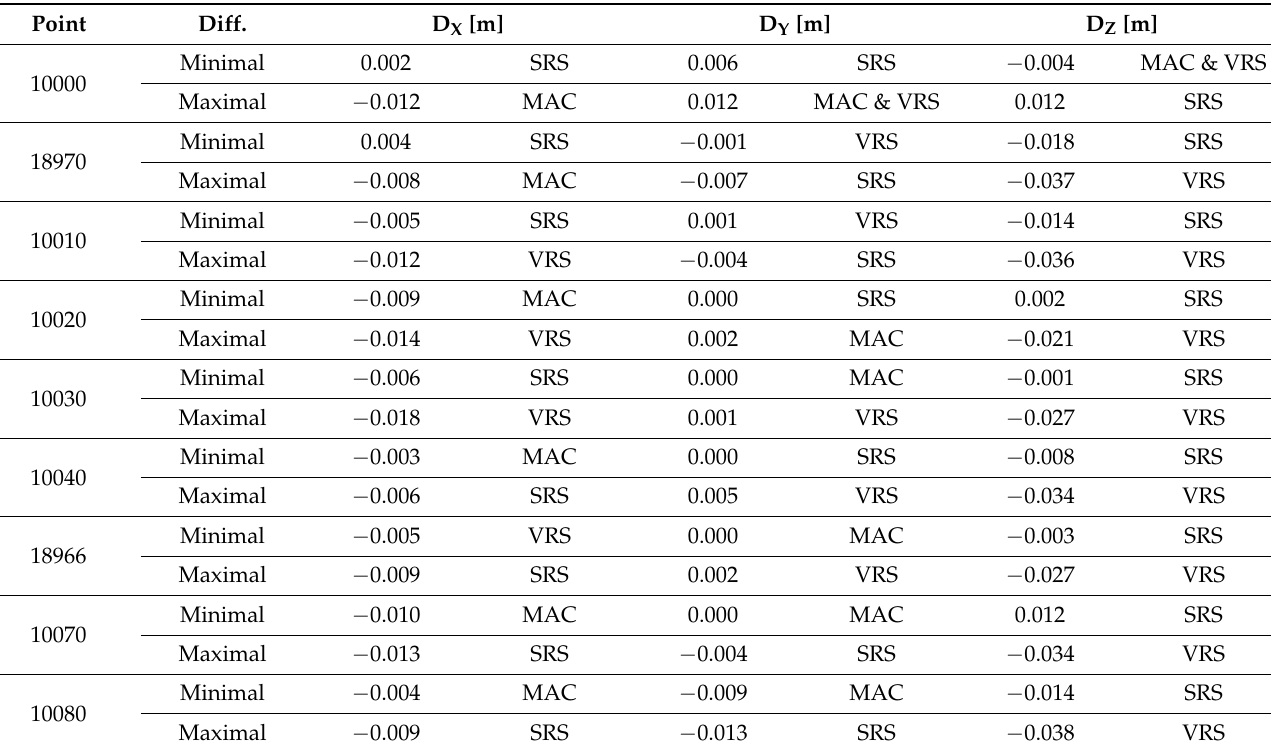
Table 3. Differences of coordinates after applying GNSS static occupation and with use of the individual type of corrections in multi-variant